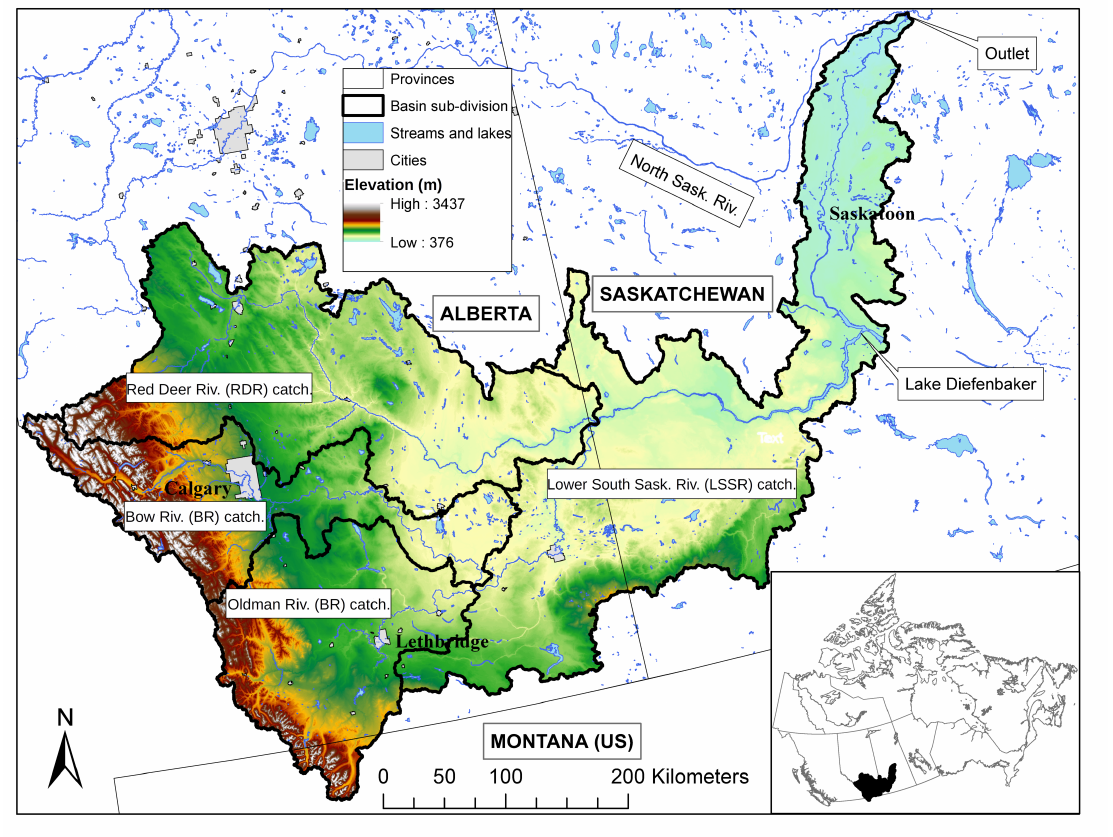
Figure 1. Geographical location of the South Saskatchewan River basin, Canada. Main rivers and water bodies, cities, basin divisions and a digital elevation model (see value colorbar for terrain elevation) are